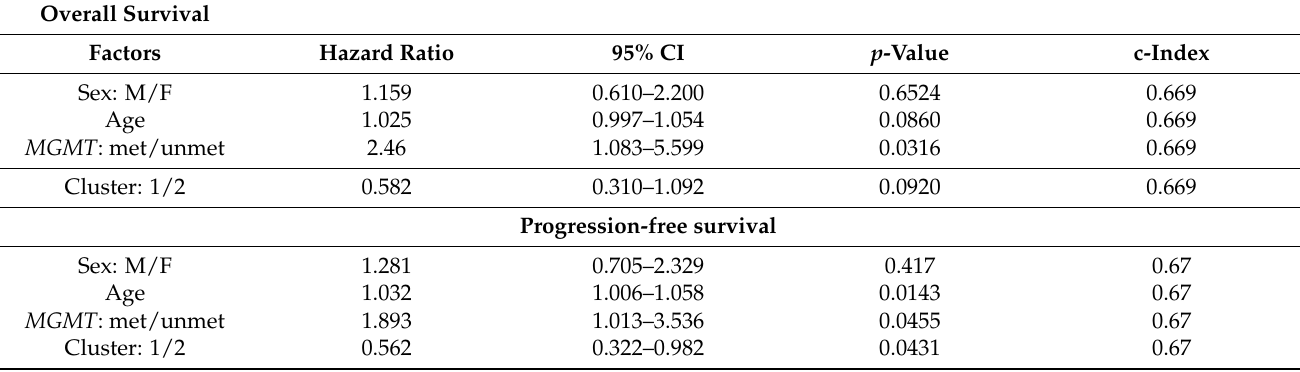
Table 2. Multivariate analysis using Cox hazard